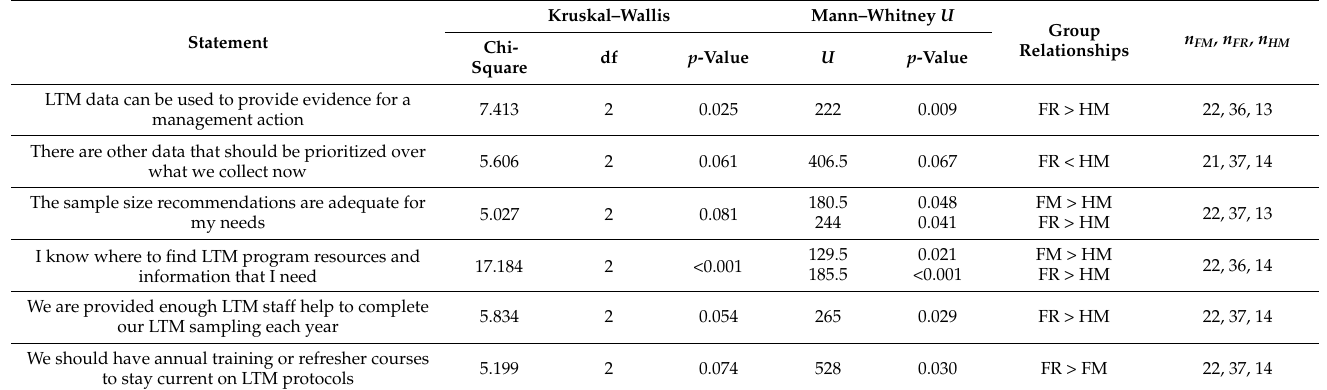
Table 6. Level of agreement with statements about Florida’s statewide Freshwater Fisheries Long- Term Monitoring (LTM) program compared among respondents’ functional roles (fisheries manage- ment, FM; fisheries research, FR; and habitat management, HM). Kruskal–Wallis tests were performed to evaluate overall functional-role differences, followed by Mann–Whitney U tests for pairwise com- parisons if differences existed. Inequalities reported under “Group relationships” denote relative levels of agreement (e.g., FR > HM indicates that fisheries researchers agreed with the statement more than habitat managers). The number of FM, FR, and HM respondents is denoted by n FM , n FR , and n HM , respectively. The survey included 21 statements, but the 6 statements with functional-role differences are reported